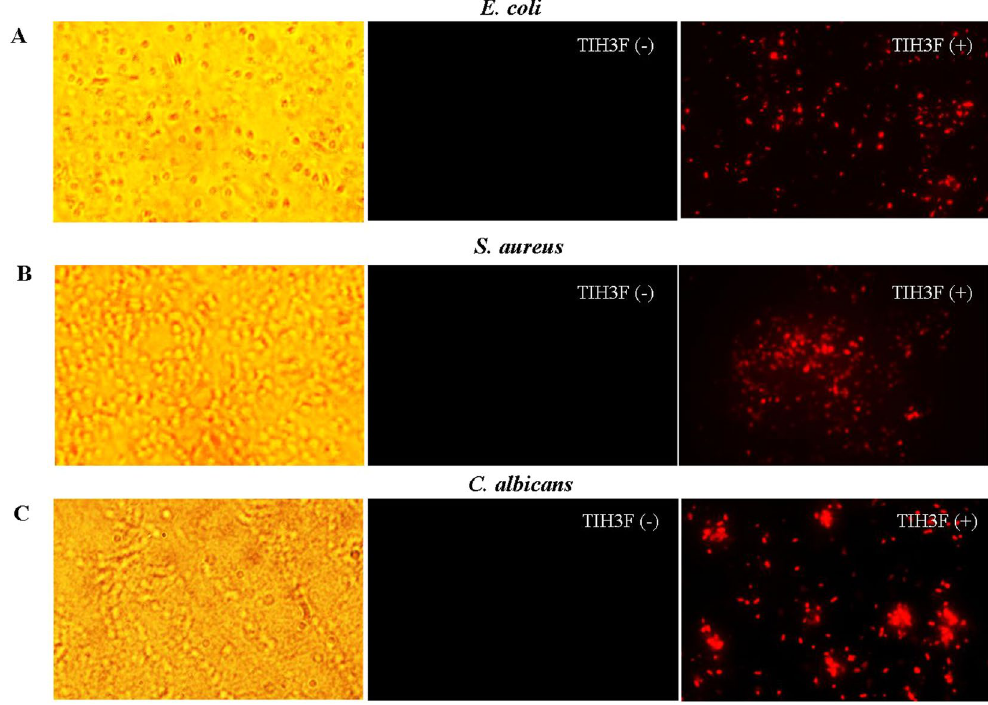
Figure 5. Membrane permeabilization of hybrid peptide on E. coli ( A ), S. aureus ( B ) and C. albicans ( C ). The microorganisms were treated with presence ( + ) or absence ( − ) of TIH3F and PI